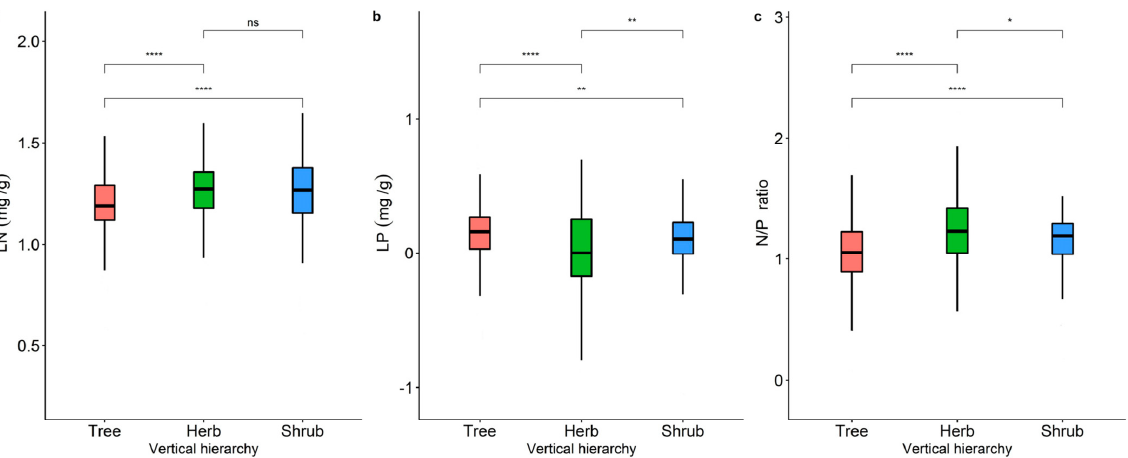
Figure 2. A comparison of the differences in the LN ( a ), LP ( b ), and N/P ( c ) at different life forms. ( a ) Variability of LN among the trees, shrubs, and herbs; ( b ) variability of LP among the trees, shrubs, and herbs; ( c ) variability of N/P among the trees, shrubs, and herbs. Tree represents the tree levels, Shrub represents the shrub levels, and Herb represents the herb levels. Levels are grouped where ns represents non − significant ( p > 0.05) at the 0.05 level, * represents p < 0.05, ** represents p < 0.01, **** represents p < 0.0001.